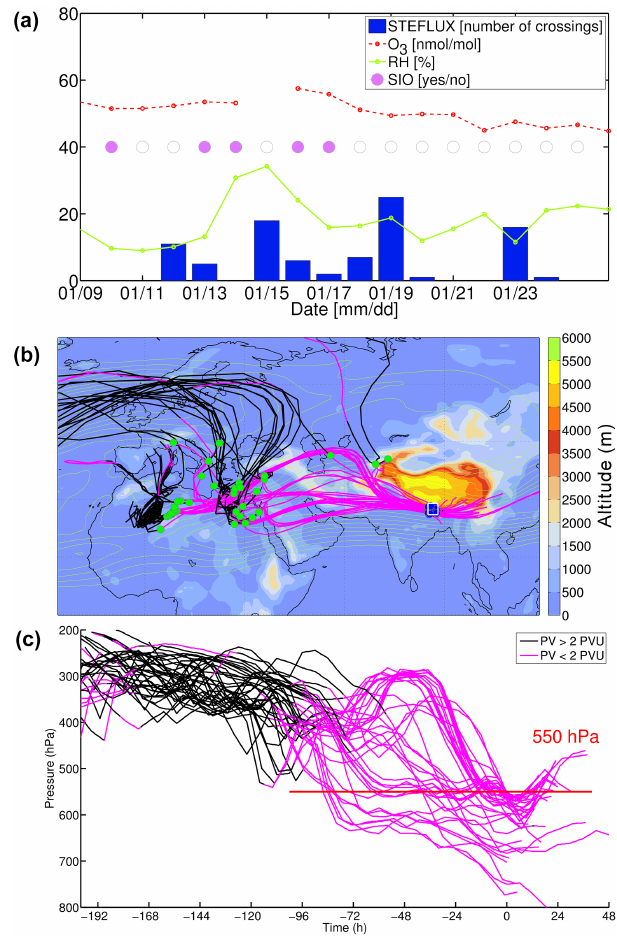
Figure 1. Example of application of STEFLUX, in a target box around NCO-P position over the period 9–25 January 2007. Panel (a) shows the daily averages for O 3 and RH at NCO-P, the days se- lected by the SIO methodology (see Sect. 2) and the number of STE trajectory points crossing the box. The STE trajectories are also dis- played entirely in (b) , where blue dots indicate the first crossings of the target box and green dots identify the tropopause crossing lo- cations. Contour lines indicate the wind speed at 250hPa, averaged over the case study period. Panel (c) shows the time–height evolu- tion of the selected trajectories (0 is the time of arrival into the target box), as a function of the PV value along each trajectory